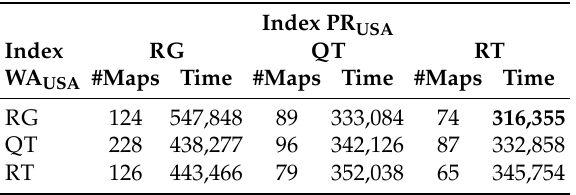
Table 7. Result of experiments with joins on real datasets regarding the primary roads and the water areas of the